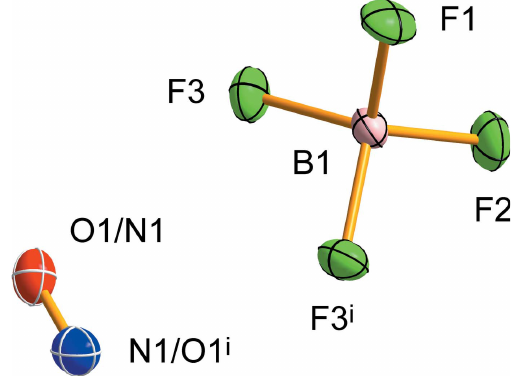
Figure 1 Expanded asymmetric unit of NOBF 4 with the atom-labelling scheme.